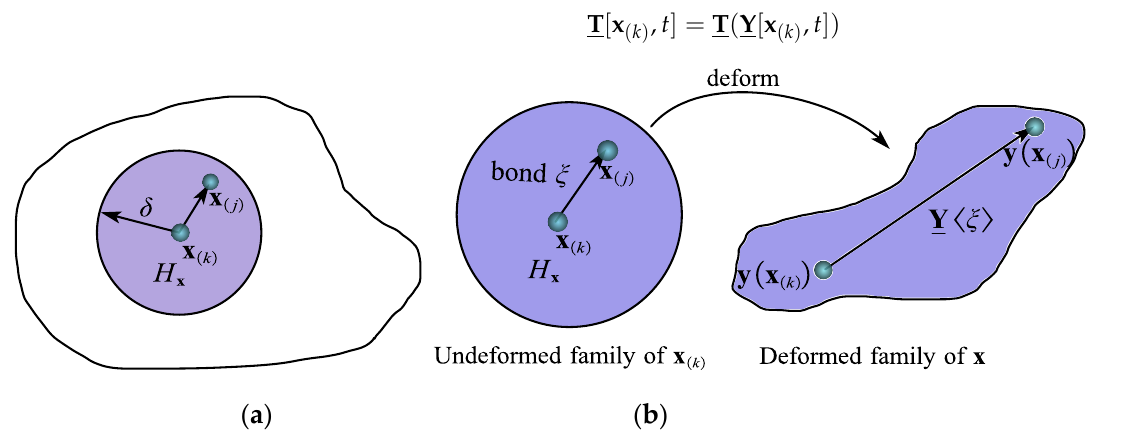
Figure 2. The force state of state-based peridynamic theory. ( a ) Example peridynamic domain; ( b ) deformation state Y (cid:104) ξ (cid:105) acting on bond ξ . All relative position vectors in the particle’s horizon x (